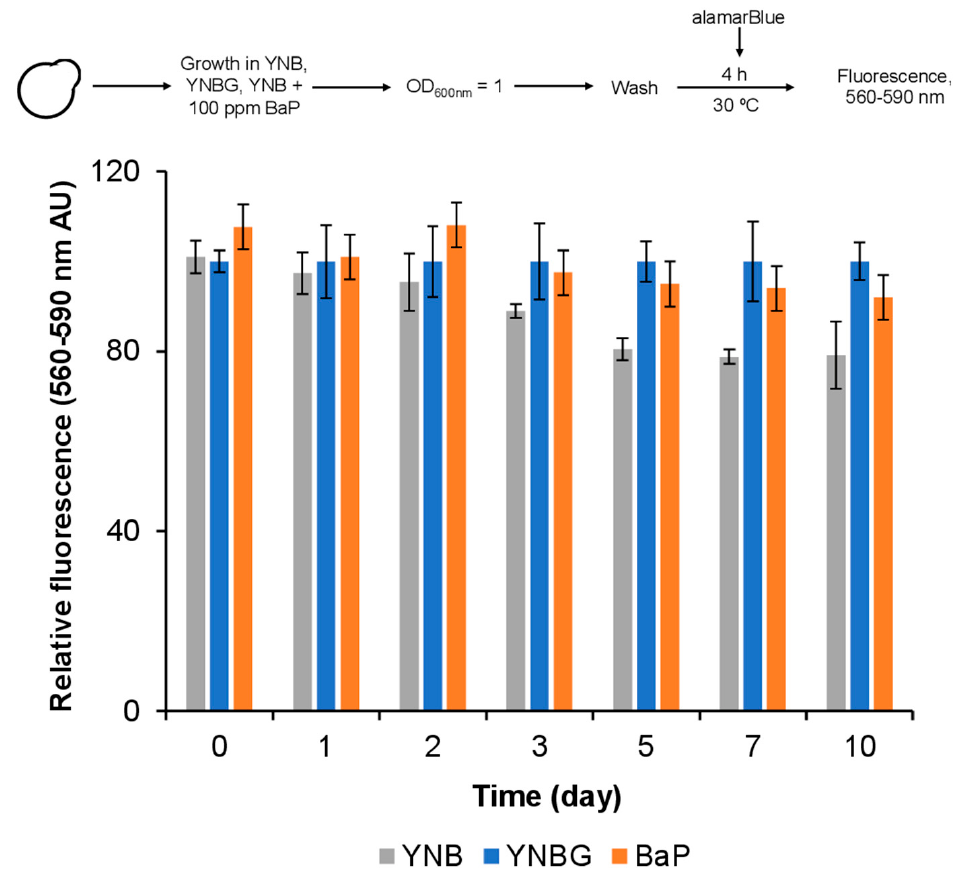
Figure 5. Long-term viability of D. hansenii in the presence of 100 ppm BaP. Cells were grown in YNB or YNB supplemented with either glucose or 100 ppm BaP during 1 to 10 days. After the respective time, an aliquot was used to assess cell viability using an alamarBlue TM kit, as indicated in Section 2. The fluorescence reading of those cells grown in YNB containing glucose was established as the 100% viability value. Results are shown as average value ± SD of three independent experiments performed by quadruplicate.